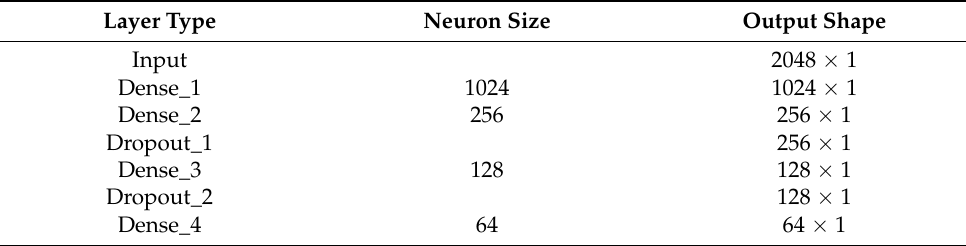
Table 4. The parameters of the proposed Siamese network with